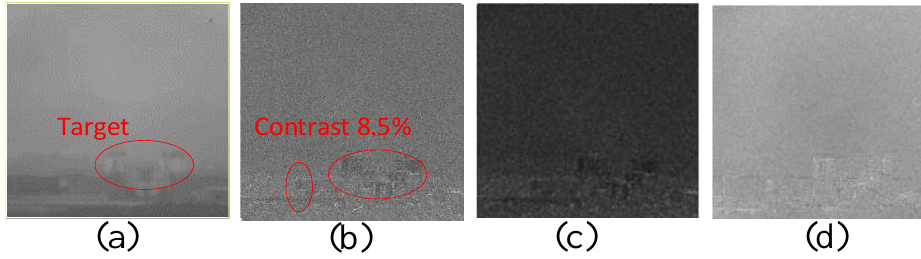
Figure 6. 670 nm band image ( a ) Intensity images ( b ) Polarization images ( c ) Line polarization images ( d ) Polarization angle images.